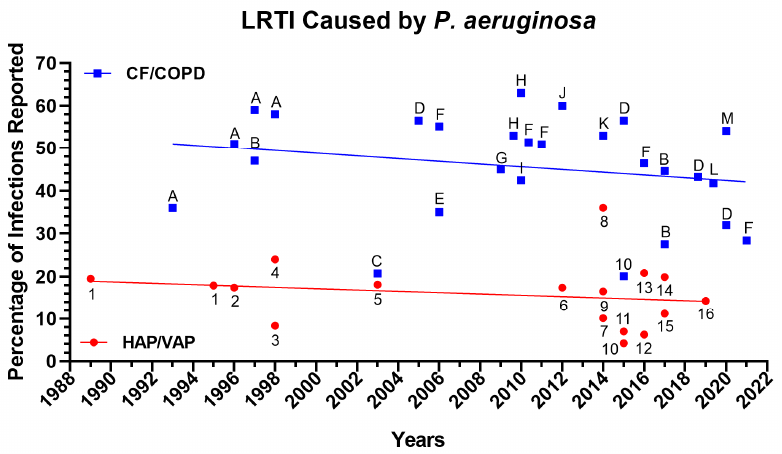
Figure 2. Lower respiratory tract infection (LTRI) rates of P. aeruginosa . Reported rates of hospital- associated and ventilator-associated pneumonia (HAP/VAP) over the past 3 decades (1989–2019) and the regression line for the data are in red. The rates for patients with cystic fi brosis (CF) or chronic obstructive pulmonary disease (COPD) and the associated regression line are in blue. The numbers and le tt ers associated with the red circles and blue squares, respectively, indicate the ref- erence numbers. References for HAP/VAP: 1. [5], 2. [6], 3. [22], 4. [19], 5. [7], 6. [21], 7. [11], 8. [23], 9. [10], 10. [24], 11. [12], 12. [15], 13. [16], 14. [17], 15. [25], 16. [8]. References for CF/COPD : A. [26], B. [27], C. [28], D. [29], E. [30], F. [31], G. [32], H. [33], I. [34], J. [35], K. [36], L. [37], M. [38], 10. [24]. Figure 3. Rates for bloodstream infections caused by P. aeruginosa in hospitalized patients over the past 3 decades (1989–2019). Hospital-acquired infections included bloodstream infections and cath- eter-associated bloodstream infections, catheter-associated urinary tract infection, surgical site in- fections and burn wound infections, and hospital-associated and ventilator-associated pneumonia; although not every article reported every category, most included at least three. Each circle repre- sents the rate reported in the study, and the year corresponds to the last collection date of the data. The solid blue line represents the linear regression of the infection rate over the years excluding